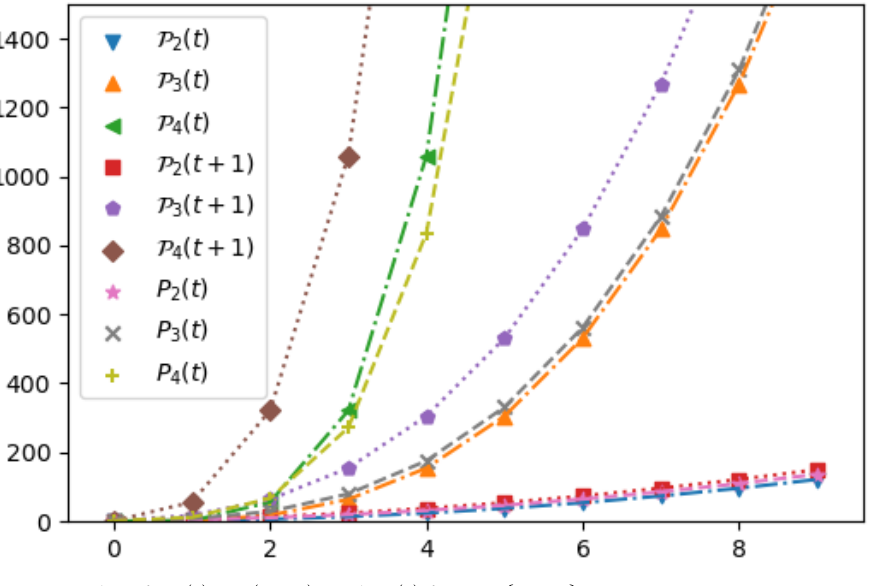
Figure 1. Plot of P n ( t ) , P n ( t + 1 ) , and P n ( t ) for n ∈ { 2,3,4 } . The delay-difference Equation (14) can be written as a third-order linear difference equation with polynomial